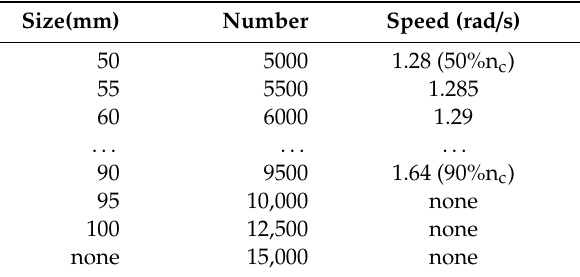
Table 2. Values of parameters for cross-over